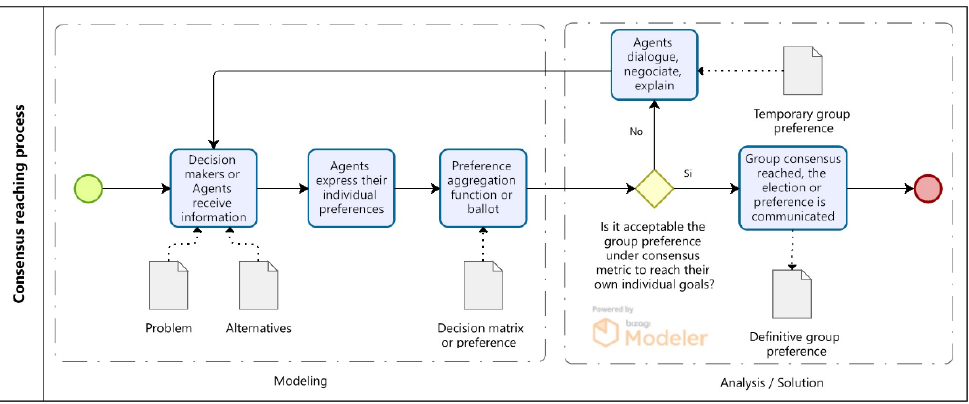
Figure 25. Consensus reaching process.